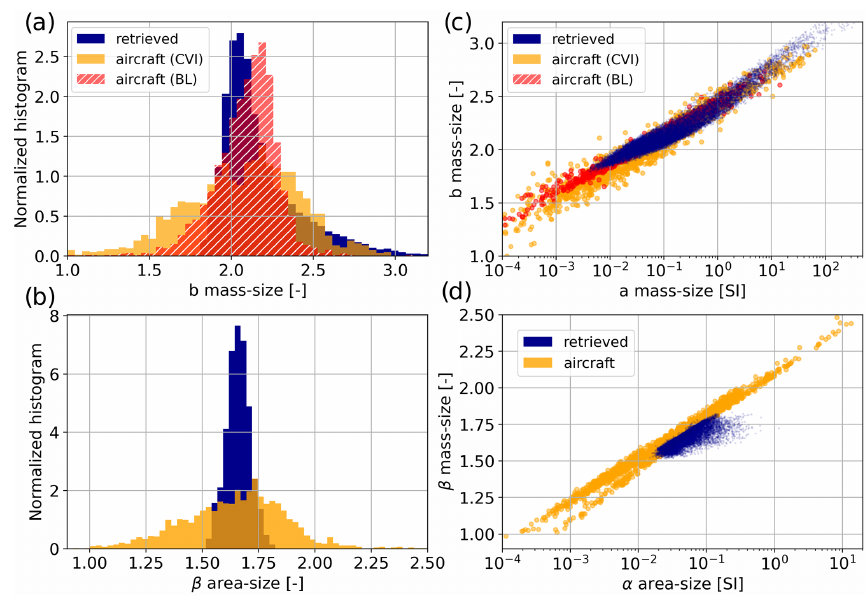
Figure 10. Histograms of (a) mass–size and (b) area–size exponents. Scatter plots of (c) mass–size and (d) area–size exponent to prefactor, from retrieval and aircraft measurements (see Sect.